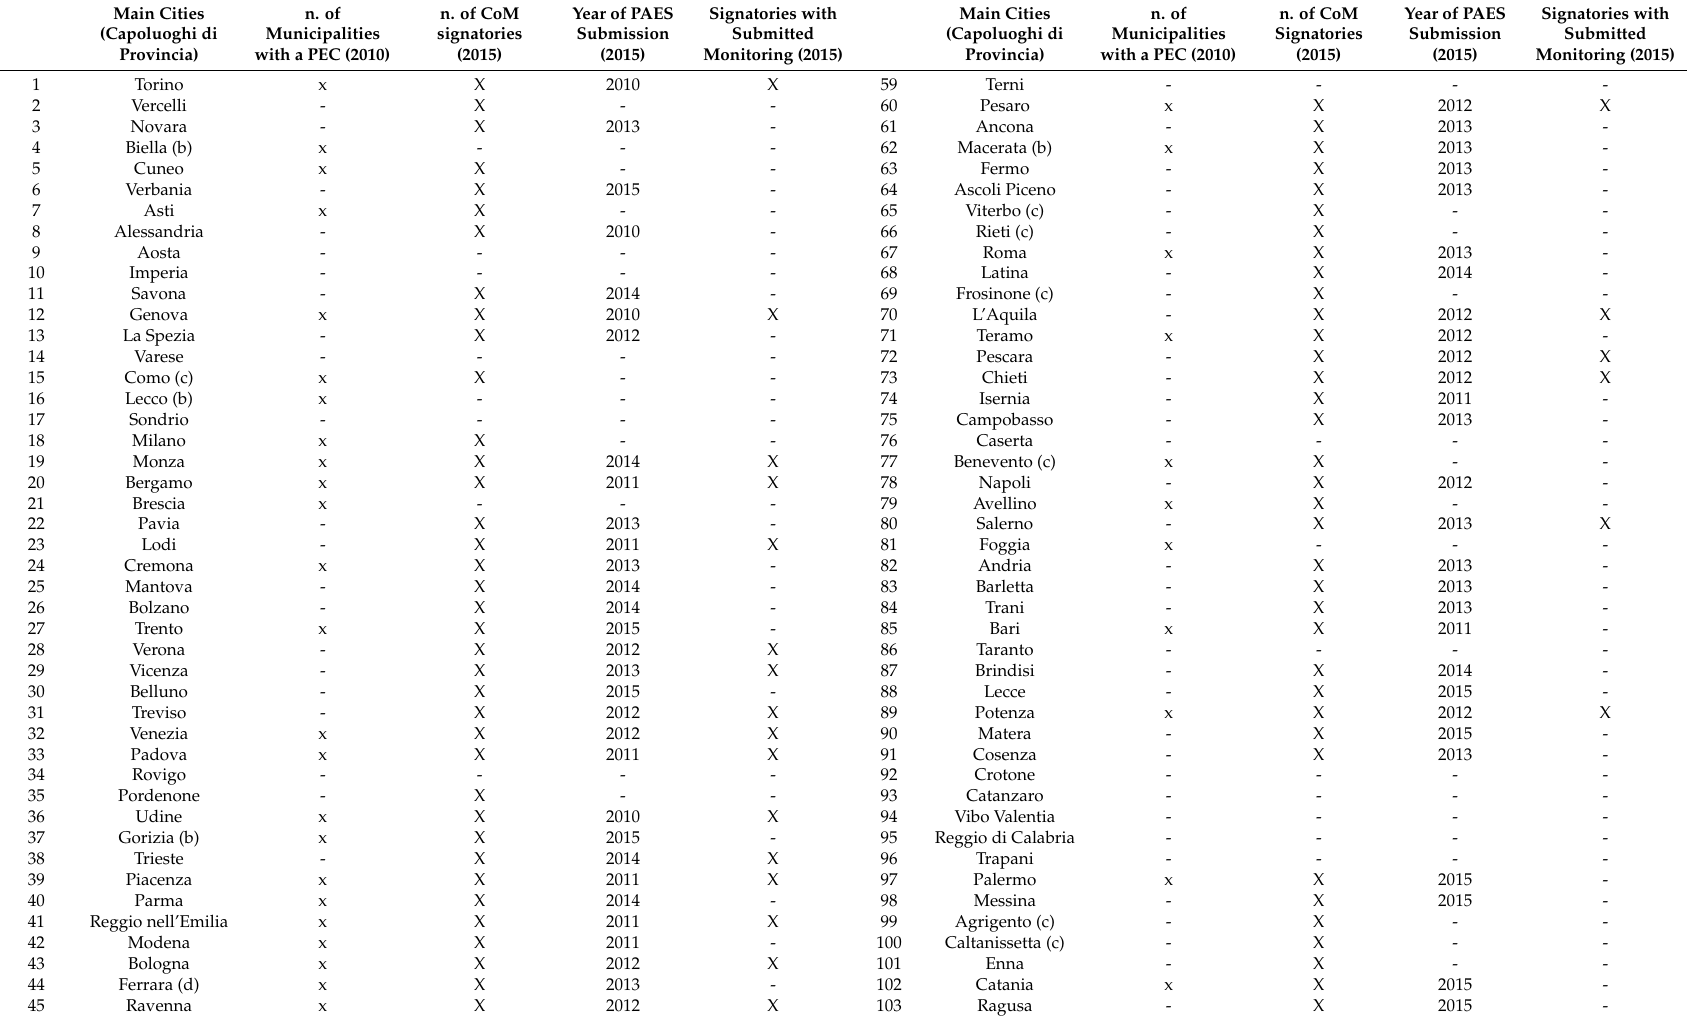
Table 1. Overview of Italian cities with an Urban Energy Plan and the shifting to the Sustainable Energy Action